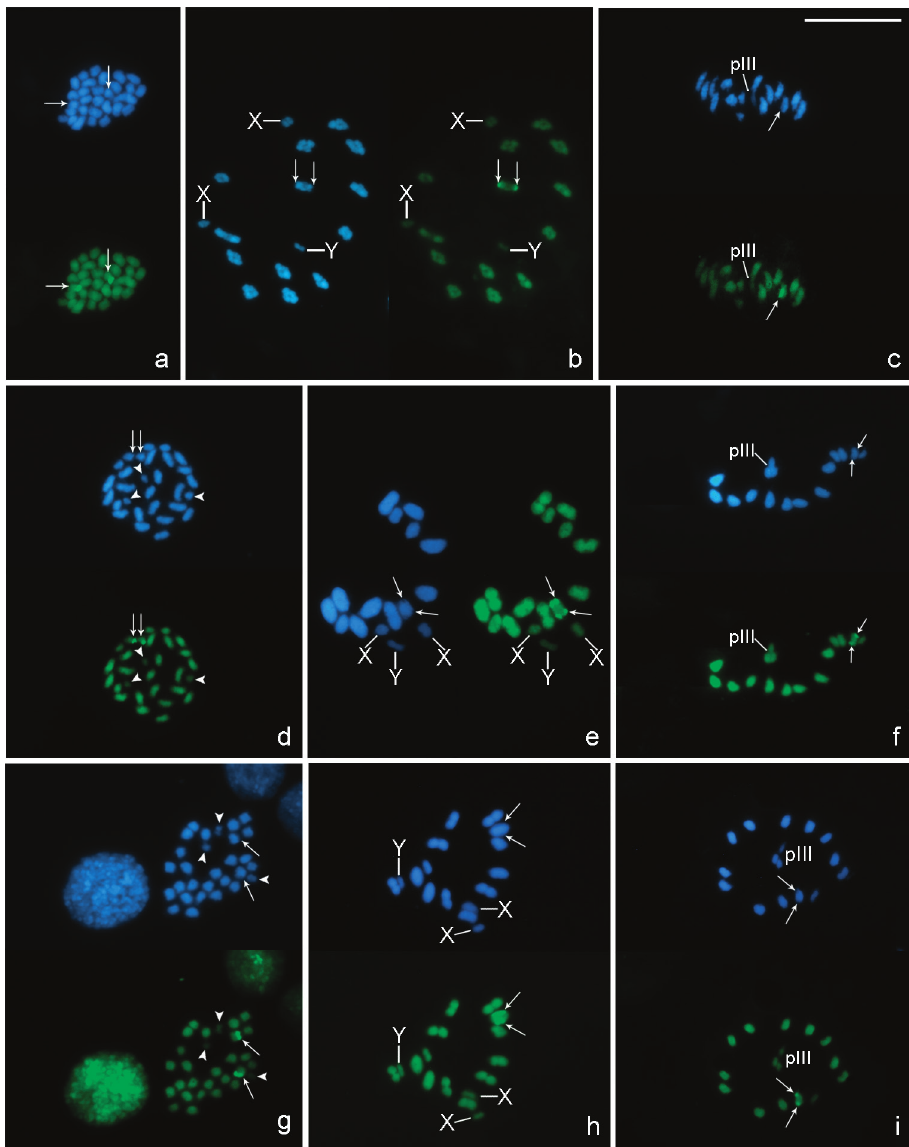
Figure 4. DAPI (blue) and CMA B. elongatum ( d–f ) and B. gestroi ( g–i ). a Oogonial metaphase (2n = 30 = 26 + X Metaphase II d Spermatogonial metaphase (2n = 29 = 26 + X matogonial metaphase (2n = 29 = 26 + X tive/CMA positive bands. Arrowheads show sex chromosomes ( d, g ). X, Y = sex chromosomes. pIII = 3 pseudo-trivalent. Bar = 10